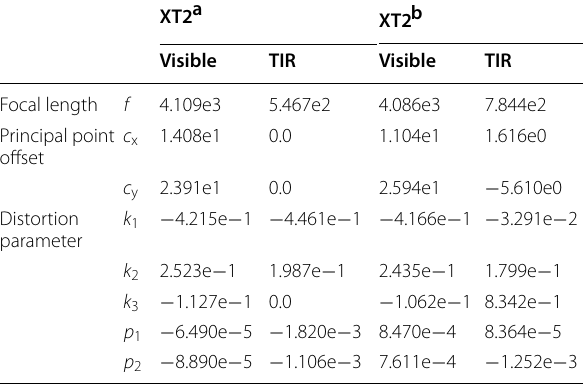
a The XT2 model, whose focus length is 9 mm used for the 2020 survey b The XT2 model, whose focus length is 13 mm used for the 2022 survey